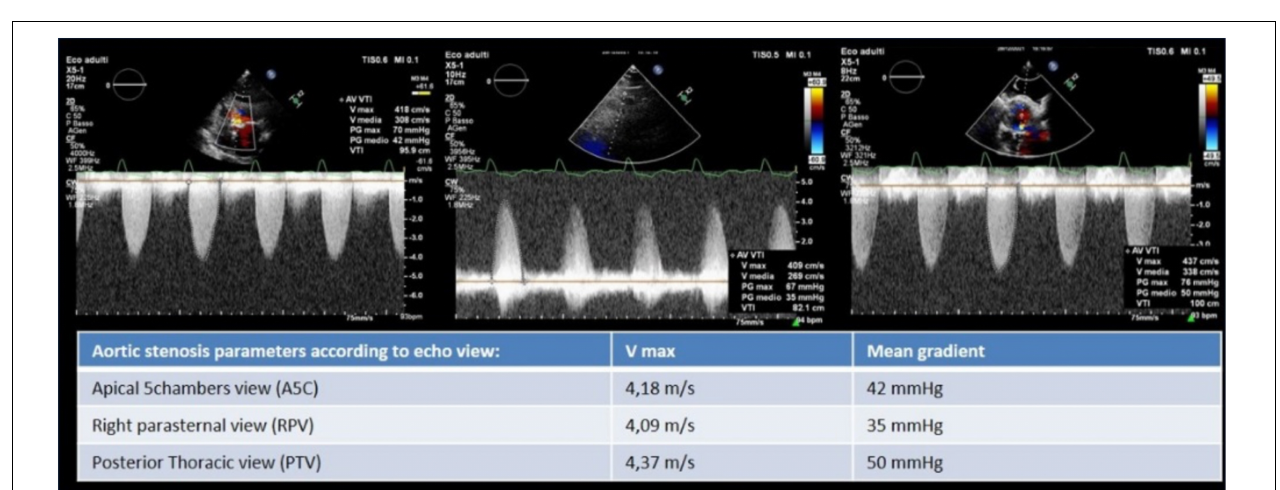
FIGURE 2 | Aortic stenosis severity evaluation by Vmax and mean gradient from apical five chambers, right parasternal, and posterior thoracic view where the latter allowed to record the highest Vmax and mean gradient.